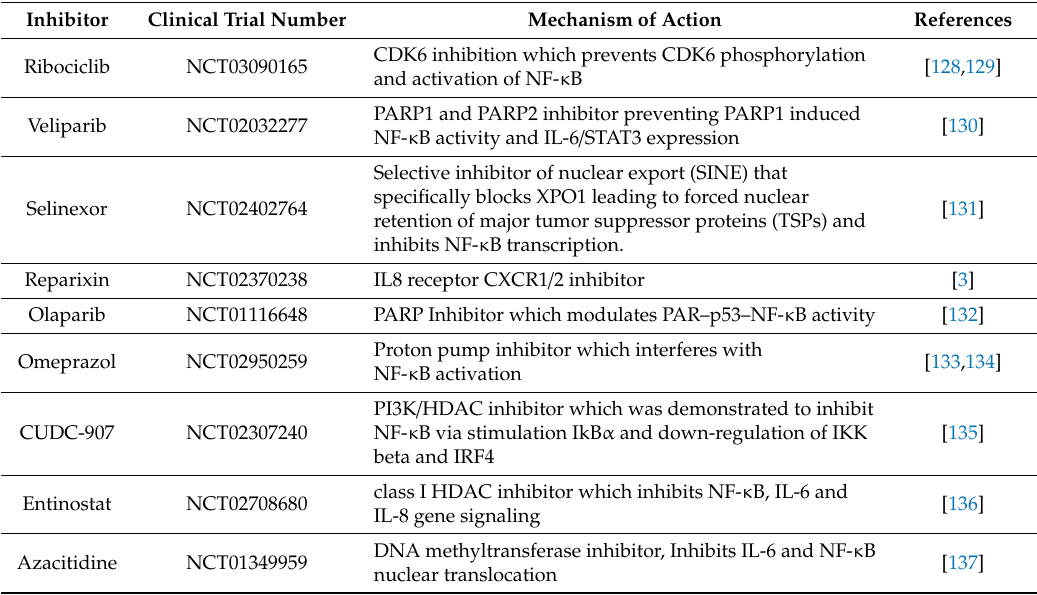
Table 3. Potential NF- κ B Inhibitors in Active TNBC Clinical